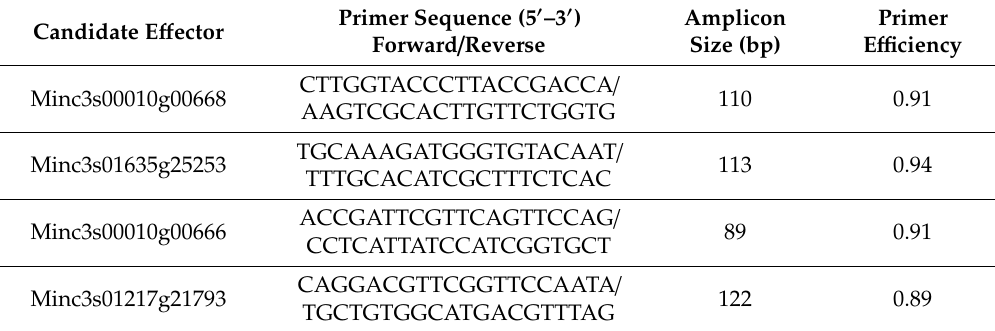
Table 1. Primers used for RT–qPCR